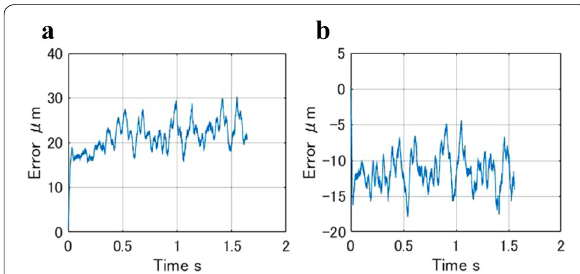
comparison of frequency responses H i and frequency responses of identified transfer functions G i . Frequency responses of identified transfer functions G i does not